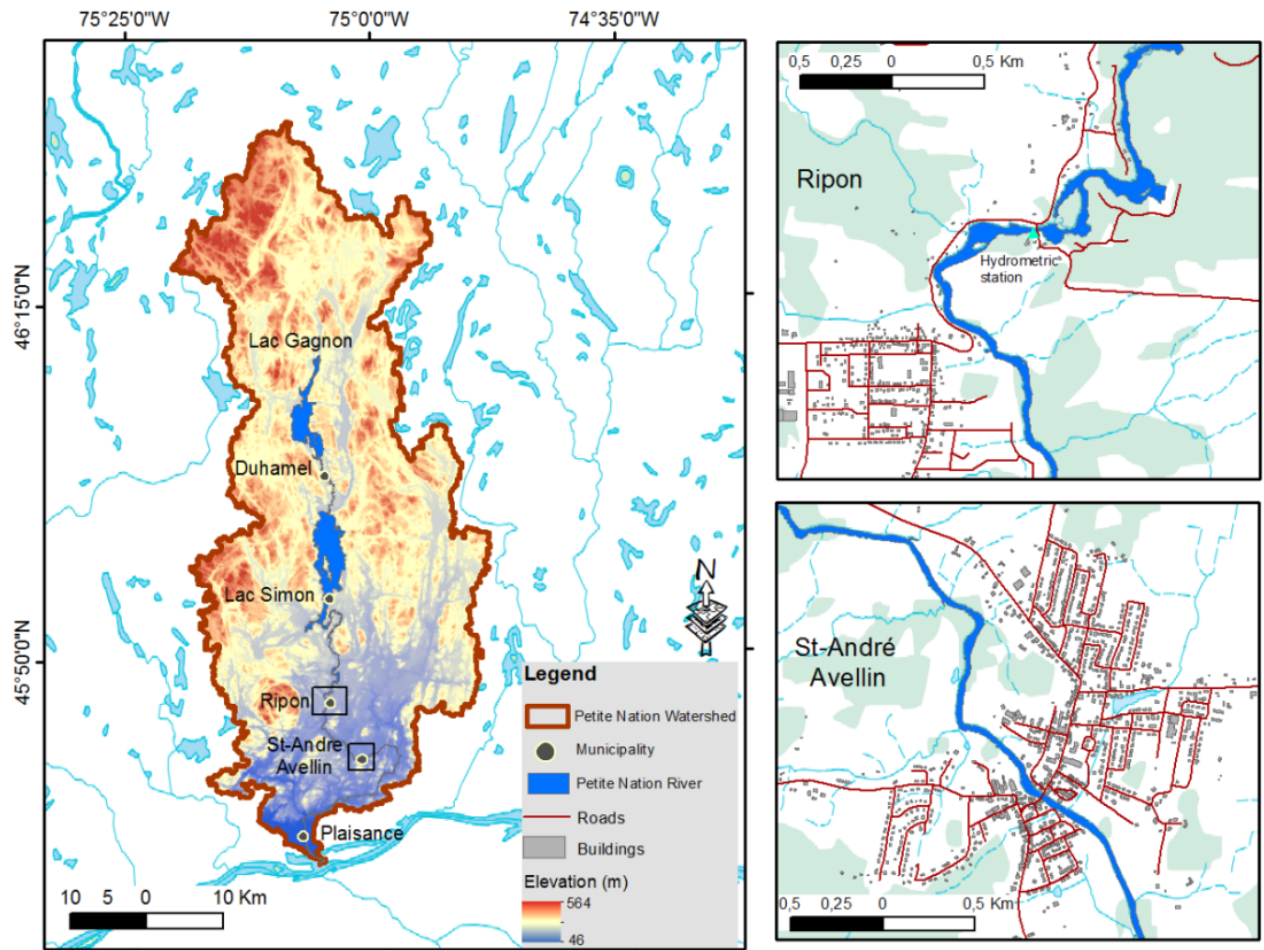
Figure 1. Location map of the study area with the two studied municipalities.